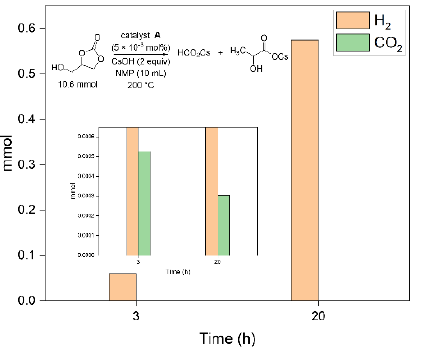
Figure 1. Gas analysis from the reaction mixture of glycerol carbonate, catalyst A , and CsOH.